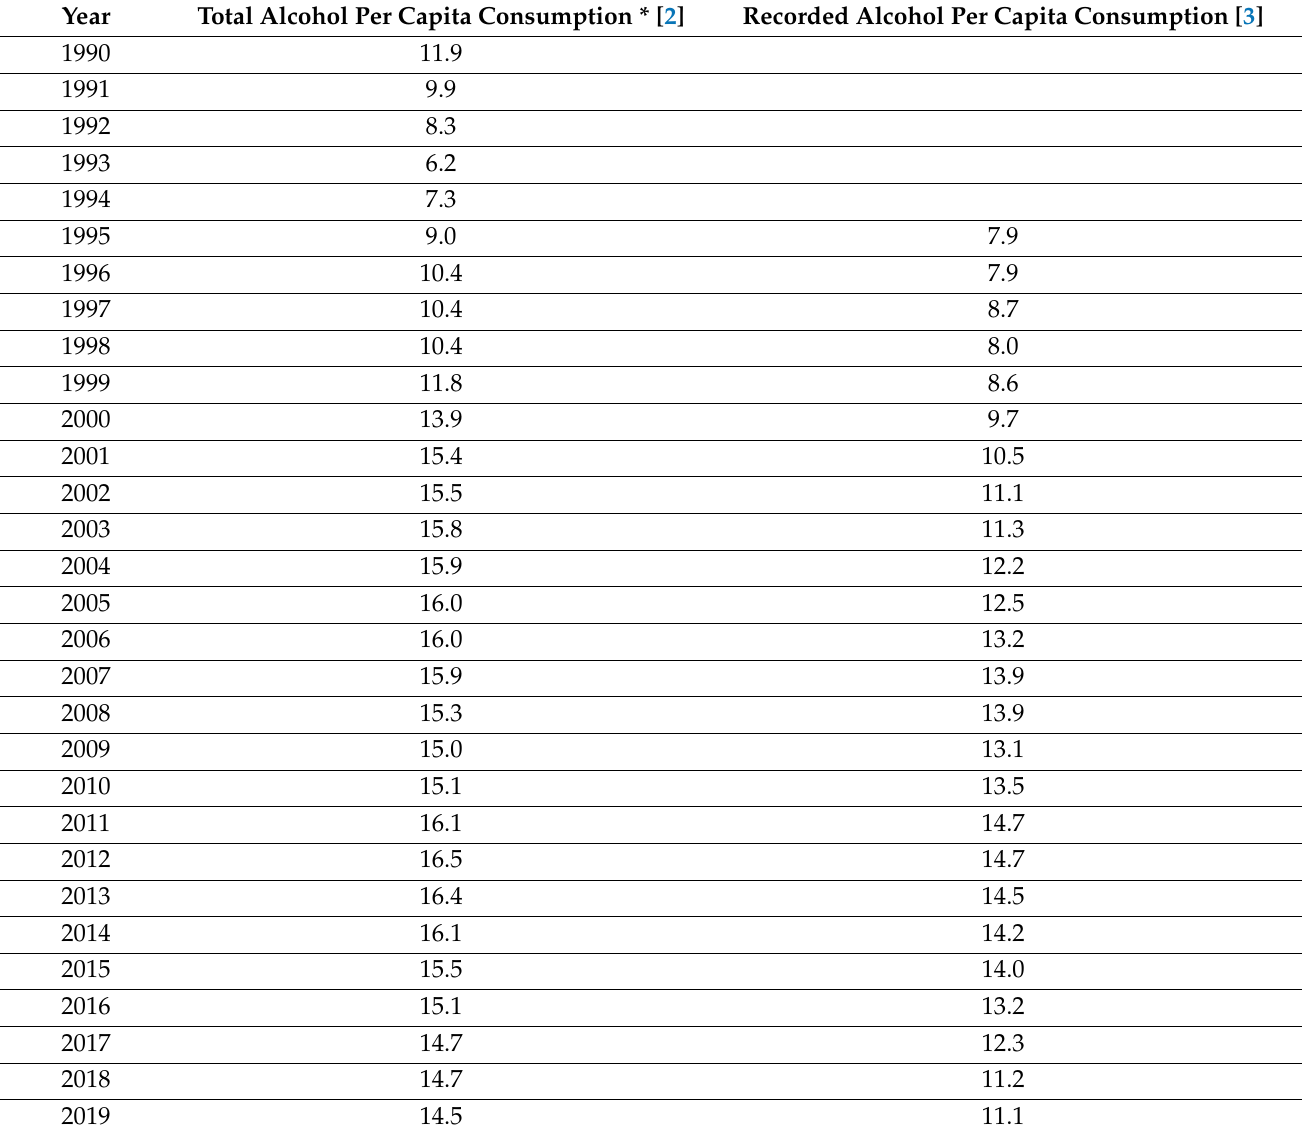
Table A1. Alcohol per capita consumption in Lithuania